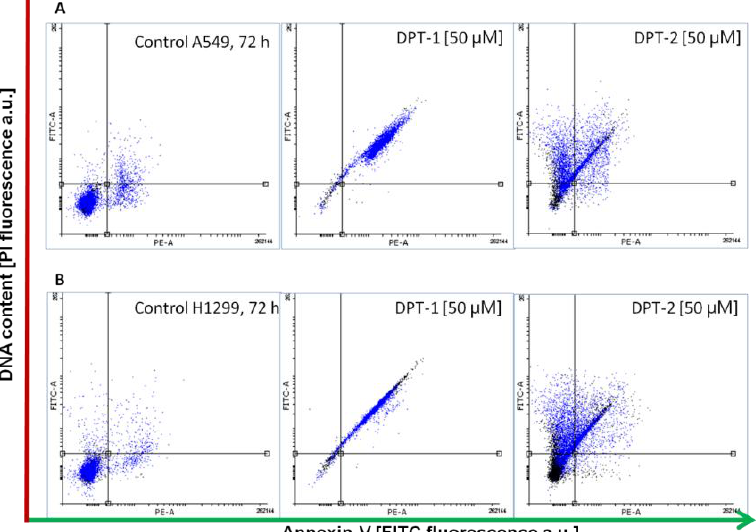
Figure 6. Typical dot plot followed by Annexin-V apoptosis assay and iodium propide (PI) staining. Cellular death in control and DPT-1 - and DPT-2 -treated A549 ( A ) and H1299 cells ( B ) treated for 72 h at a dose of 50 µ M, followed by flow cytometry measurements (normal cells: Annexin-VI − /PI − ; early apoptosis: Annexin-V + /PI − ; late apoptosis: Annexin-V + /PI + ; necrosis: Annexin-V − /PI + ). The dose of 50 µ M, almost ten times higher than the calculated IC 50 = 5.289 ± 0.004 µ